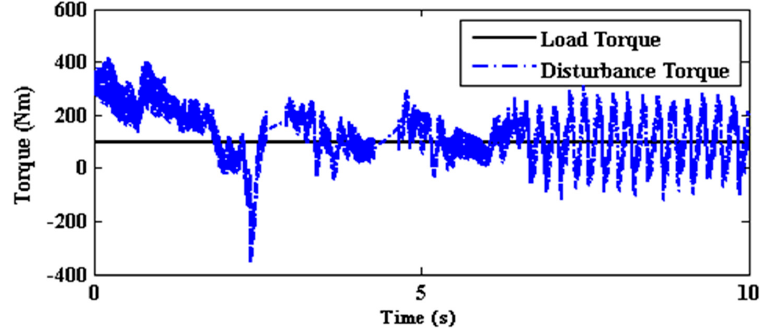
Figure 11. Estimated disturbance torque of SMLO 2.